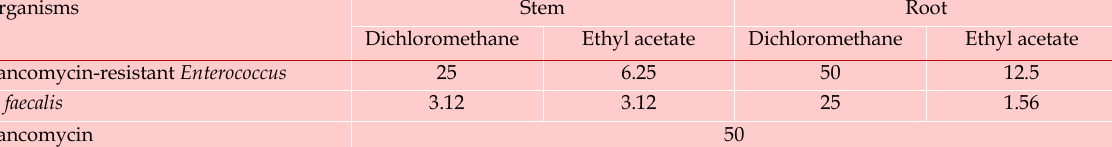
MIC of plant crude extracts